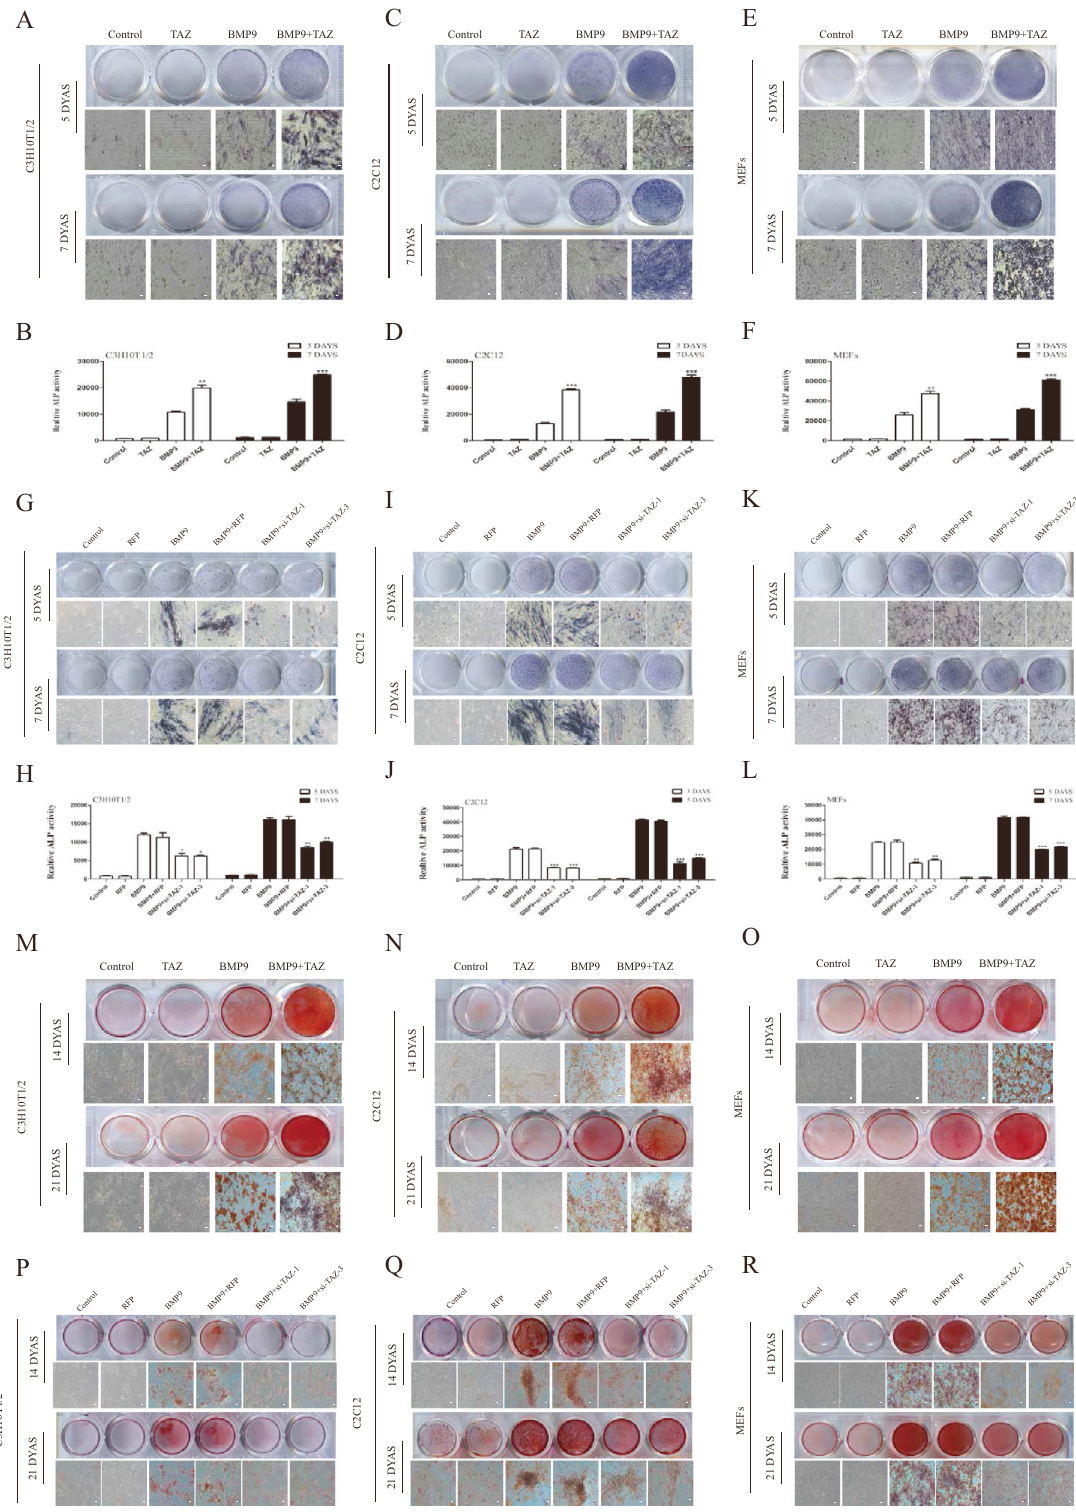
Fig. 2 The effect of TAZ on BMP9-induced early and late osteogenic differentiation in MSCs and MMCs. Cells were treated with TAZ or si- TAZ, followed by treatment with BMP9. A – L The ALP activity was performed by chemiluminescence assay and ALP staining was conducted by histochemical staining assay at 5 and 7 days. M – R Calcium deposition was analyzed by Alizarin Red S staining at 14 and 21 days. The data were shown as mean ± SD for three separate experiments. Ad-RFP adenovirus carrying red fl uorescent protein